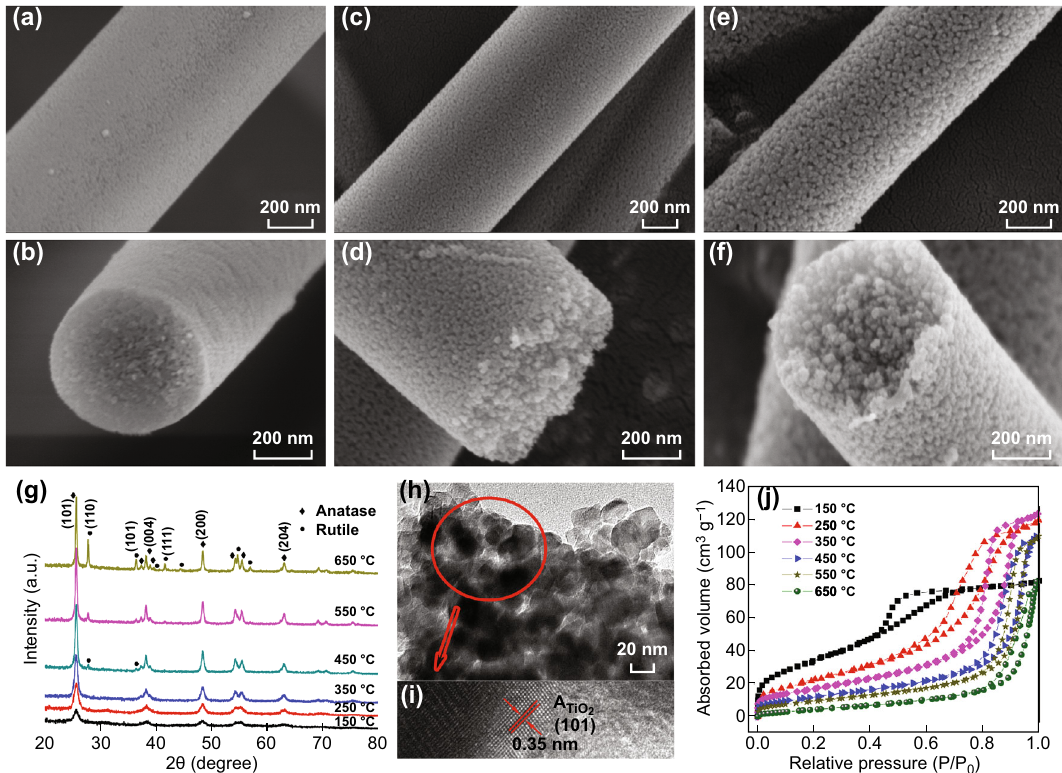
Fig. 17 SEM images of the TiO 2 nanofibers treated with water steam at different temperatures of a , b 150 (cid:3) C; c , d 350 (cid:3) C; and e , f 550 (cid:3) C. g XRD patterns of the samples heat-treated at different temperatures in water steam. h , i HRTEM and SAED images of the water steam-treated TiO 2 nanofibers prepared at 550 (cid:3) C. j Nitrogen adsorption–desorption isotherms of the samples heat-treated at different temperatures in water steam [152]. Copyright (cid:2) 2009 Elsevier